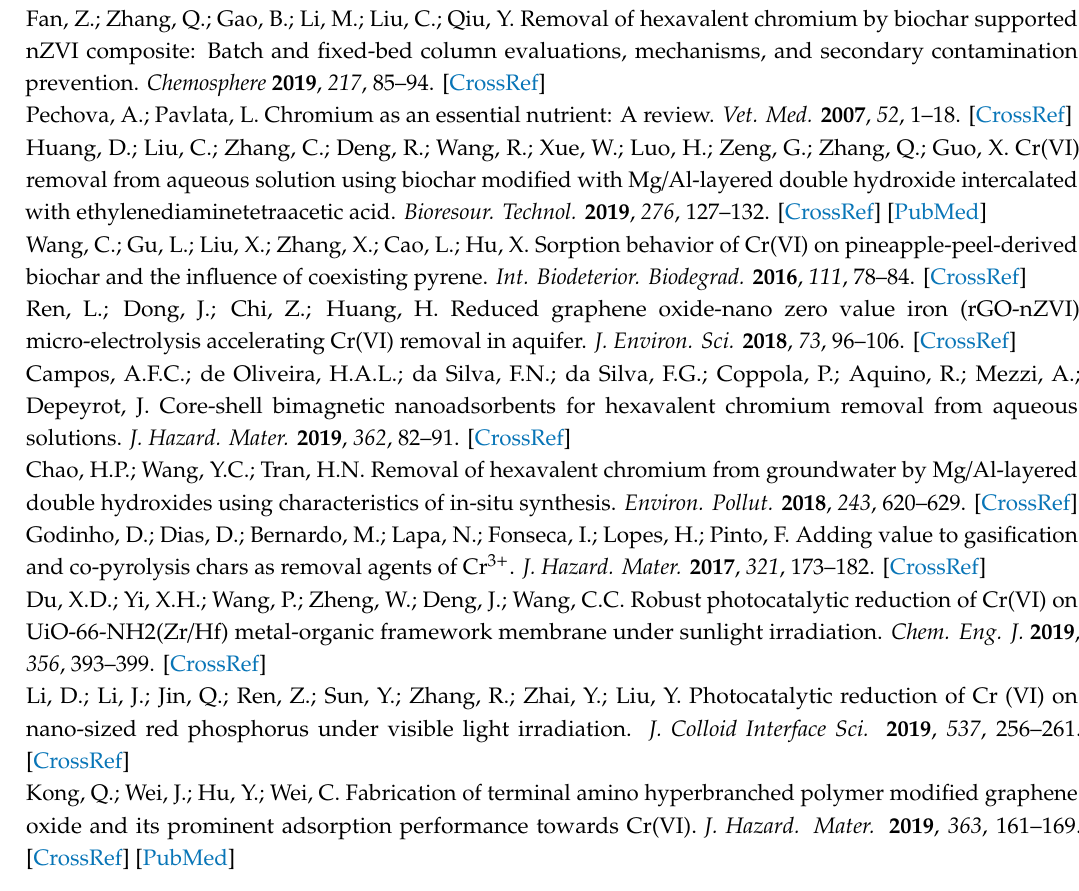
Figure S1: Adsorption of Cr(VI) by six kinds of biochar without Mg loading, Table S1: Comparison of di ff erent adsorbents, Table S2: Adsorption thermodynamic fitting